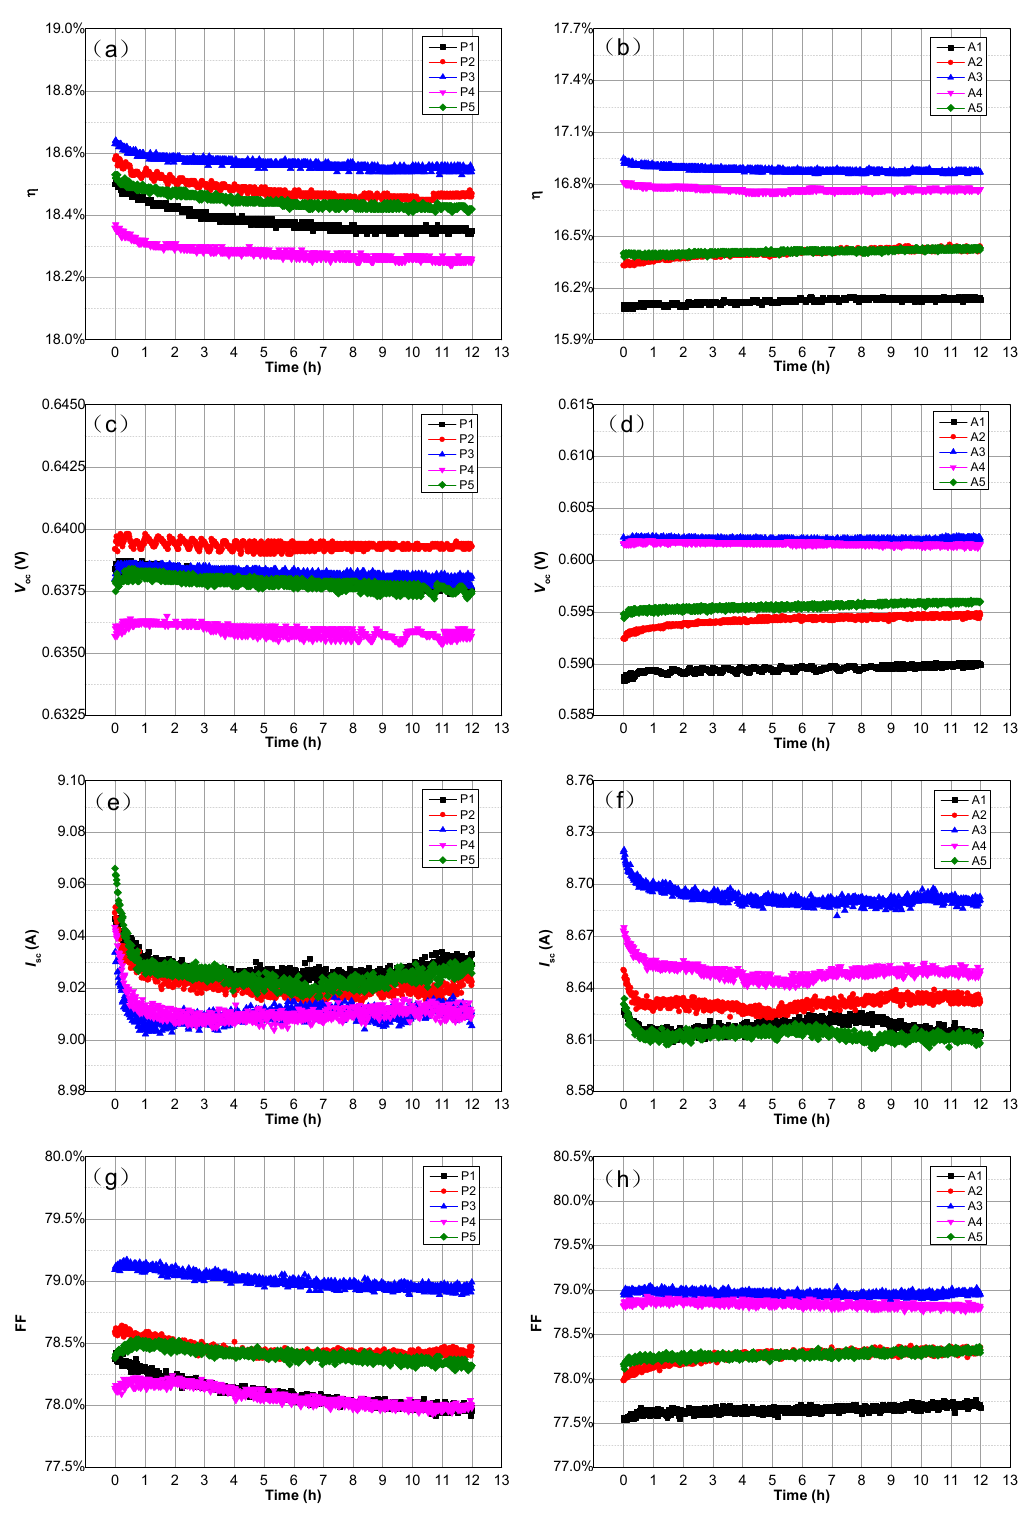
Figure 2. In situ variations of η , V oc , I sc and FF of five groups of PERC ( left column) and Al-BSF cells ( right column) with process time during the second LID (1 sun, 45 °C, 12 h). (a) η of PERC cells; (b) η of Al-BSF cells; (c) V oc of PERC cells; (d) V oc of Al-BSF cells; (e) I sc of PERC cells; (f) I sc of Al-BSF cells; (g) FF of PERC cells; (h) FF of Al-BSF cells. After the first hour of the treatment, the η , V oc and FF of Al-BSF cells and V oc of PERC cells basically remain stable; however, the η and FF of PERC cells show a slow and slight